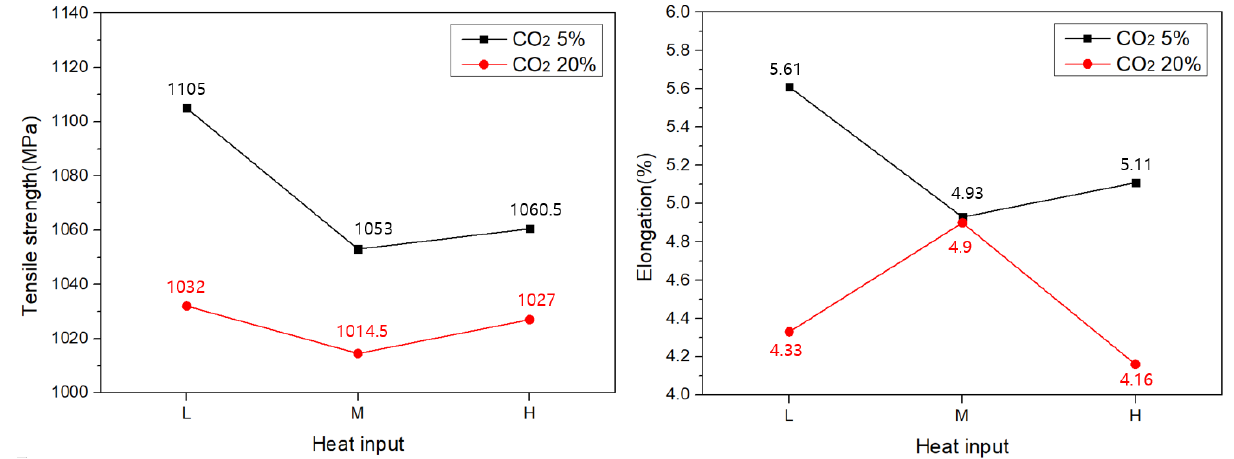
Figure 16. Tensile test results of GMAW with CO 2 5% and 20% shielding gas and heat input.